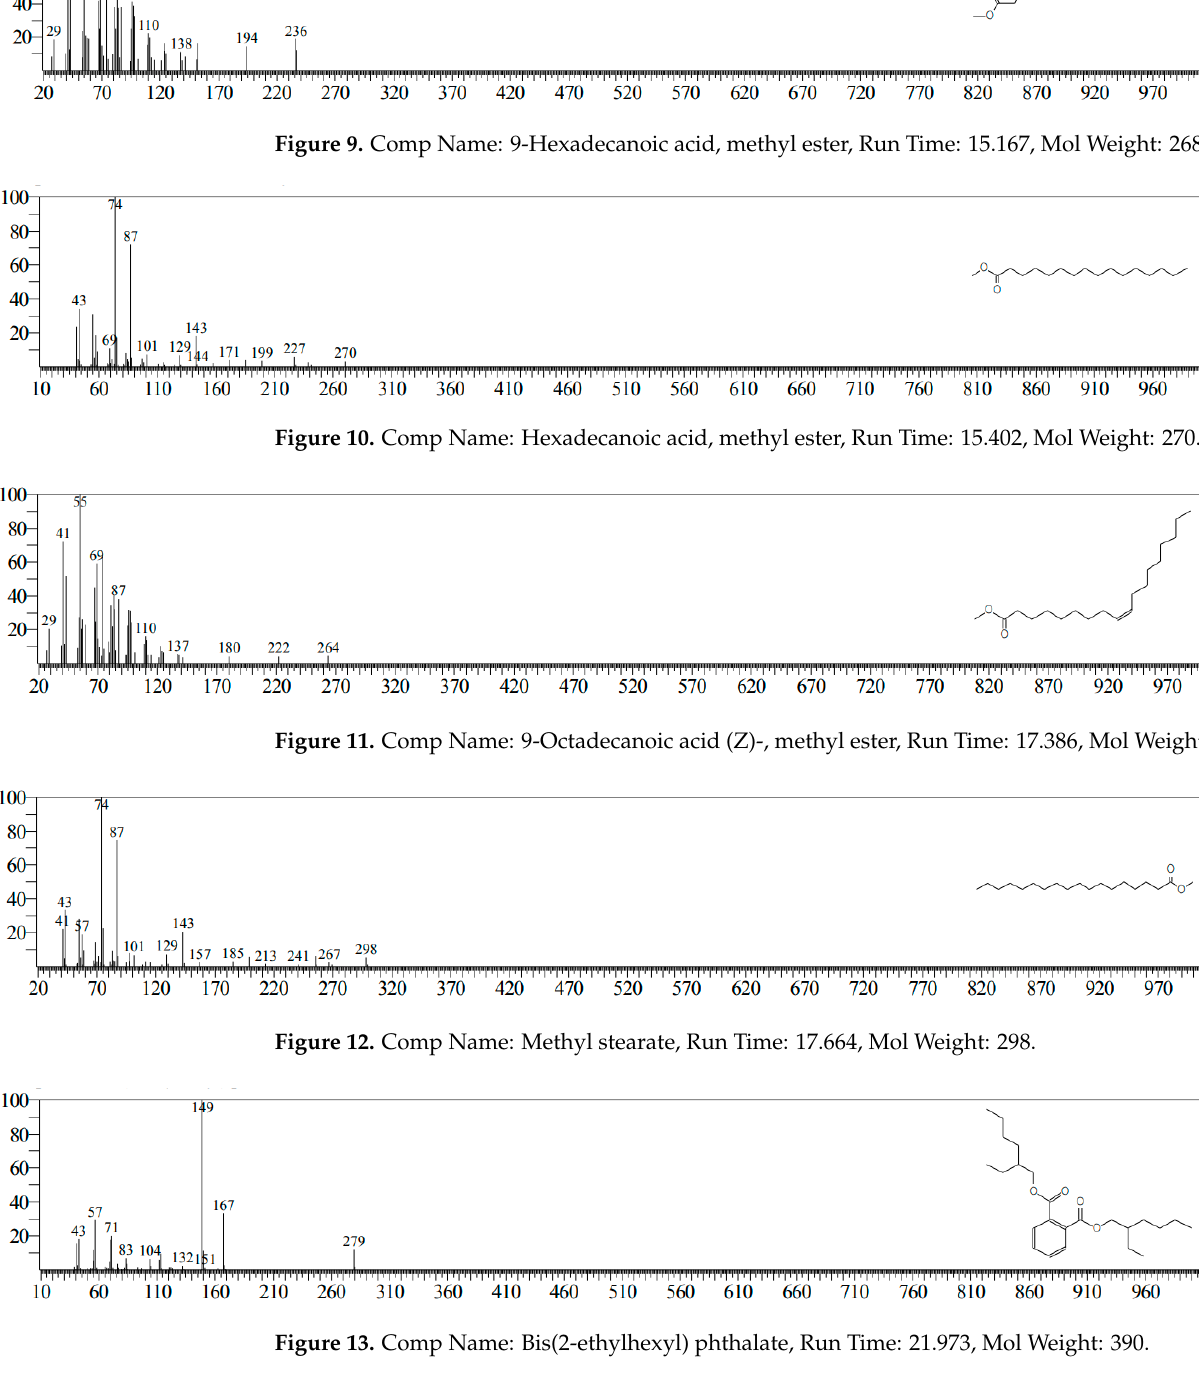
Table 3. Compounds detected from GC-MS of biodiesel.